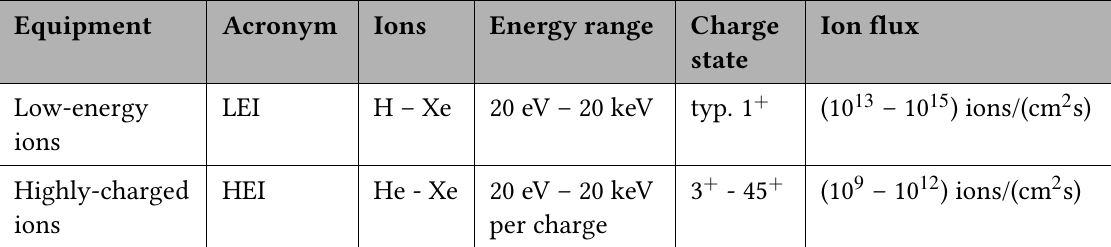
Table 4: Basic parameters of LEI / HCI tools available at IBC